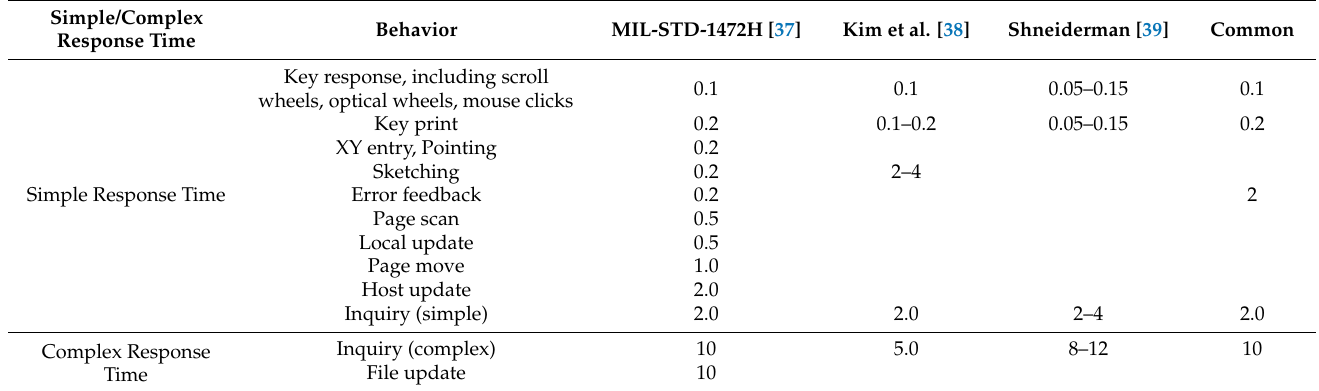
Table 6. User-Acceptable System Response Times Suggested by Relevant